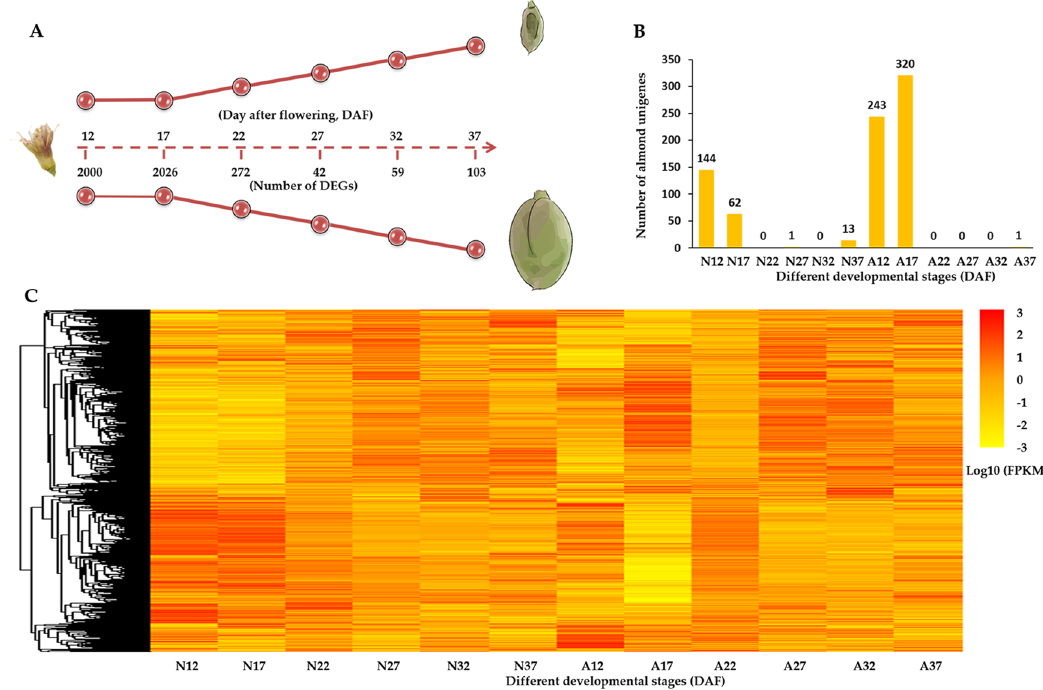
Figure 3. ( A ) The schematic graph of this study (This figure was drawn by Xinchang Li); ( B ) The number of developmental stage specific genes; ( C ) The heatmap of total DEGs. ‘N12 ′ represents 12 DAF of normal fruits; ‘A12 ′ represents 12 DAF of abnormal